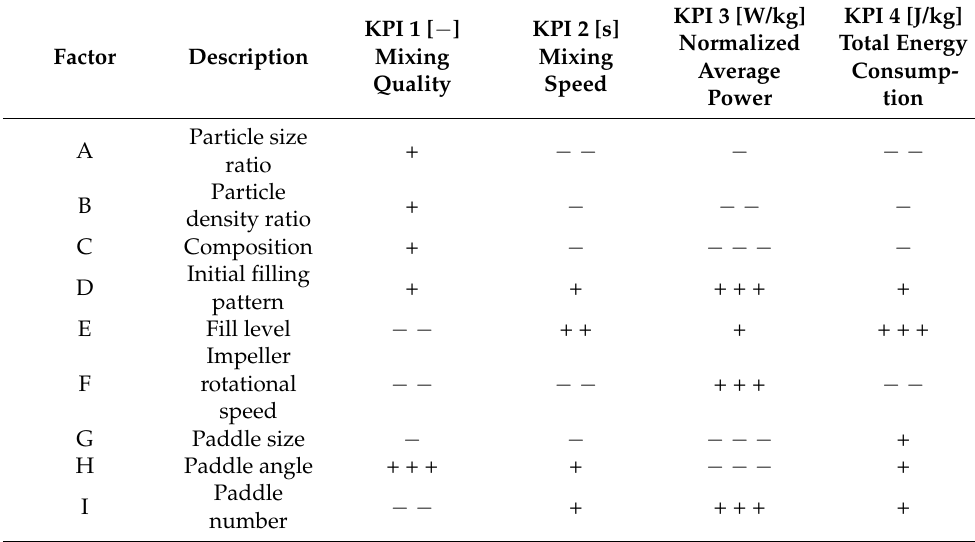
Table 10. Summary of factor response. Pluses (+) and minuses ( − ) indicate positive and negative correlations, respectively. The number of pluses and minuses indicates the factor’s significance, e.g., (+++), (++) and (+) indicate p < 0.1, 0.1 ≤ p < 0.2 and p ≥ 0.2,